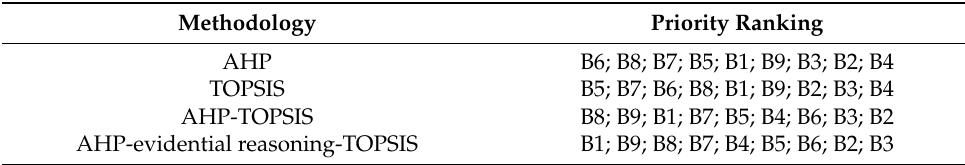
Table 7. Comparison of the proposed approach with other